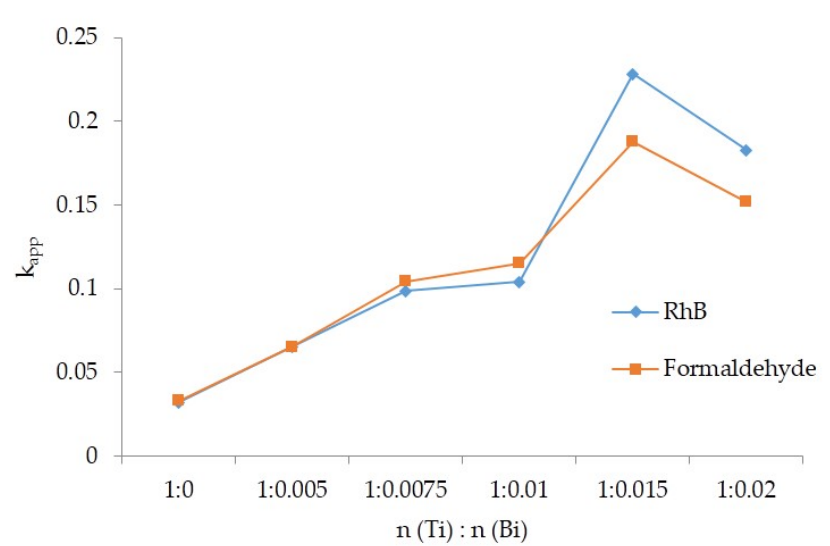
Figure 12. The rate constant of the apparent reaction of RhB and Gas Formaldehyde degraded by different Bi doping Si–Ti composite films.